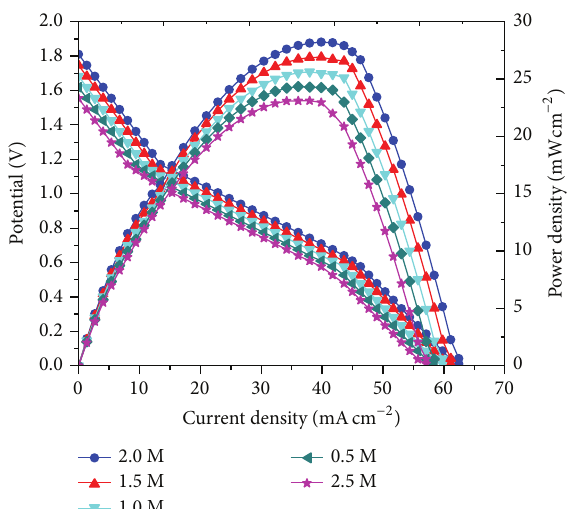
Figure 6: Effect of perborate concentration on the current and power density of the MLSPBFC at room temperature. [Fuel]: 2M formic acid + 0.5 M NaOH. [Oxidant]: 𝑥 M perborate + 0.5 M H 2 SO 4 . Stream flow rates: 0.3 mL min −1